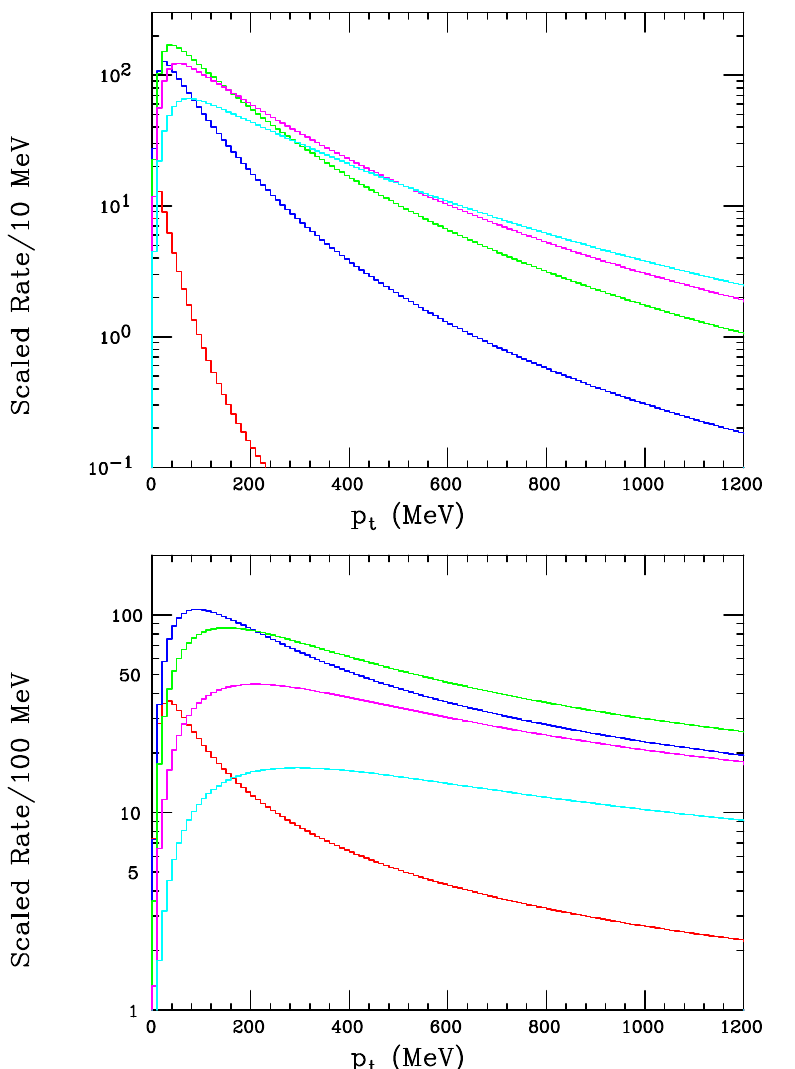
Figure 7 . Comparison of the scaled recoil electron transverse momentum distribution for the (Top) familiar vector coupling in the KM/ (cid:15) 2 scenario and that from the dark magnetic dipole model presently under consideration (Bottom) assuming that m V = 100 (red), 300(blue), 500(green), 700(magenta) and 1000(cyan) MeV, respectively. The normalization of all curves have again been floated to fit these curves into single panels and to show their details as in the previous figure so that only overall shape comparisons are relevant